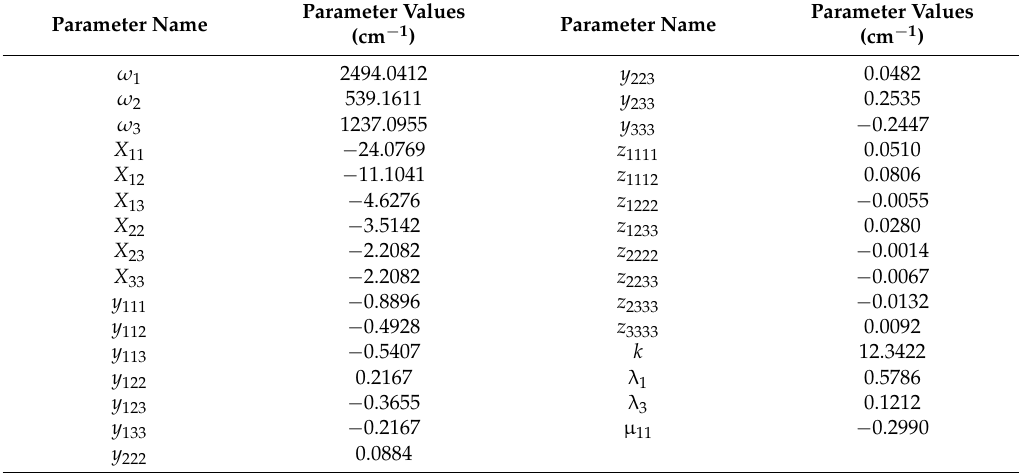
Table 1. The coefficients of vibration Hamiltonian of deuterated phosphaethyne